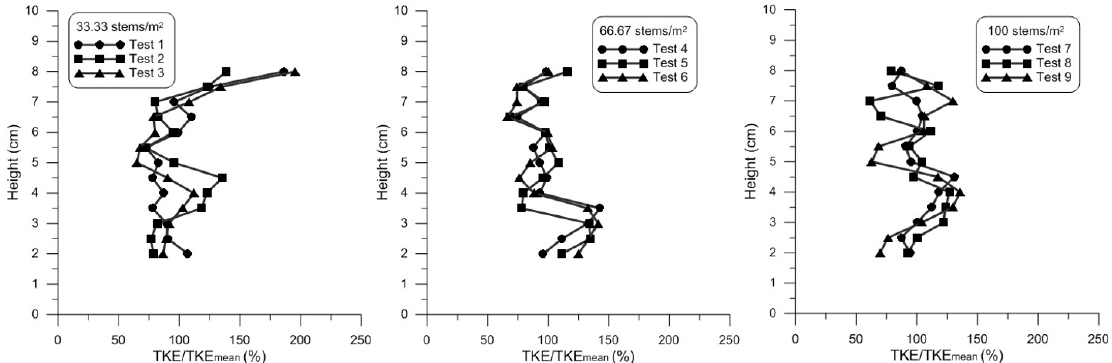
Figure 9. Turbulent kinetic energy variation under the different densities.